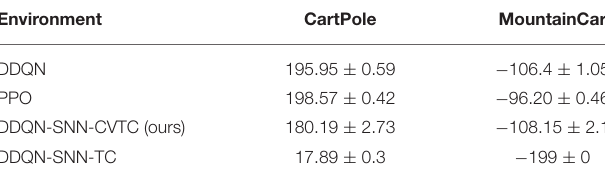
TABLE 4 | Comparison of performance on Gym basic